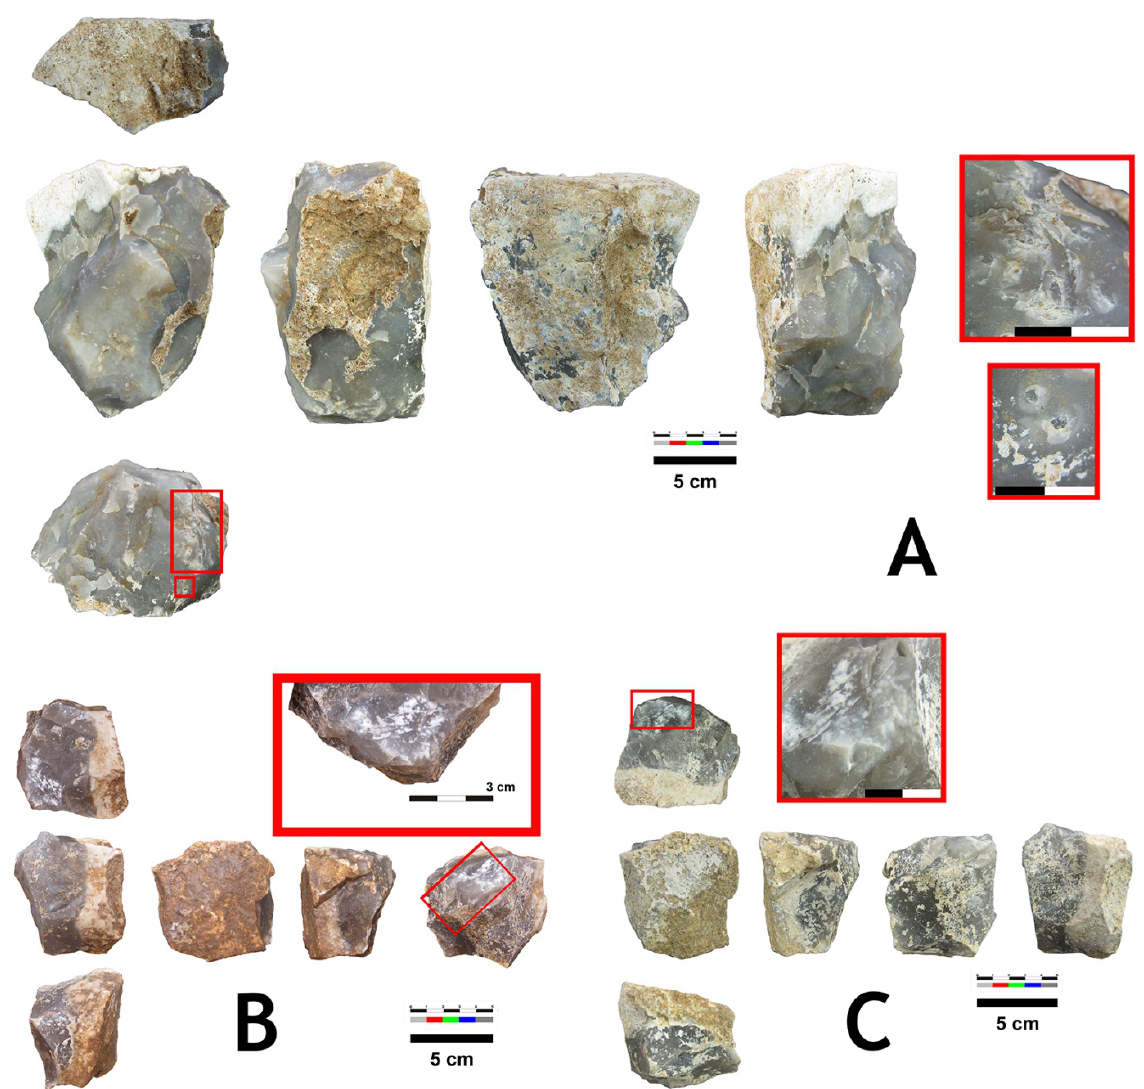
Figure 9. Selected flint hammerstones from the site CPD30. A) Large flint hammerstone. B & C) Hammerstones with isolated and less intense percussion